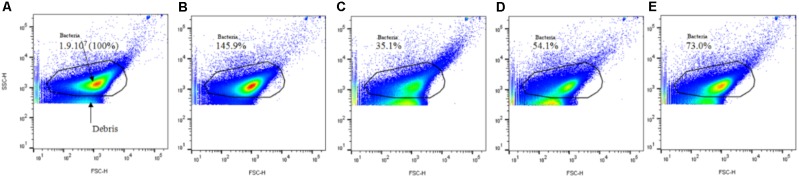
Selection of the Staphylococcus aureus population by FC based on FSC and SSC parameters. Effect of 15 min of NTP treatments. (A) Control: number of events/mL; (B) 15 min low pressure; (C) 15 min O2; (D) 15 min Ar; (E) 15 min N2. (B–E) Expressed as a percentage of the control population.